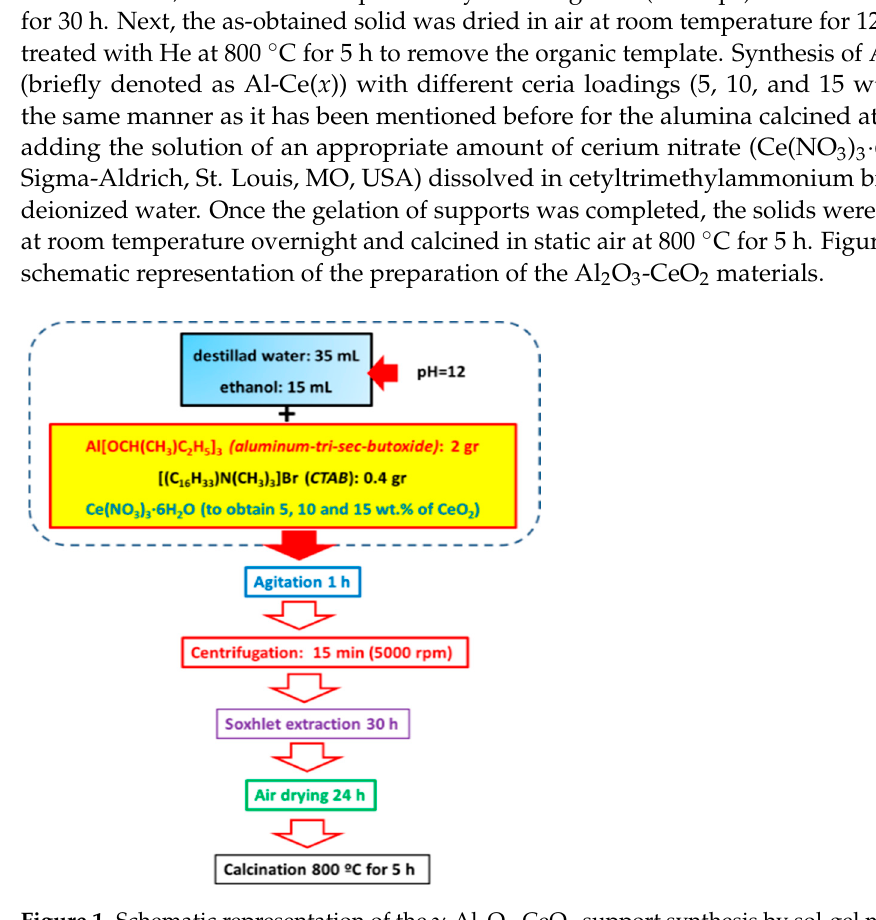
Figure 1. Schematic representation of the γ‐ Al 2 O 3 ‐ CeO 2 support synthesis by sol ‐ gel method.